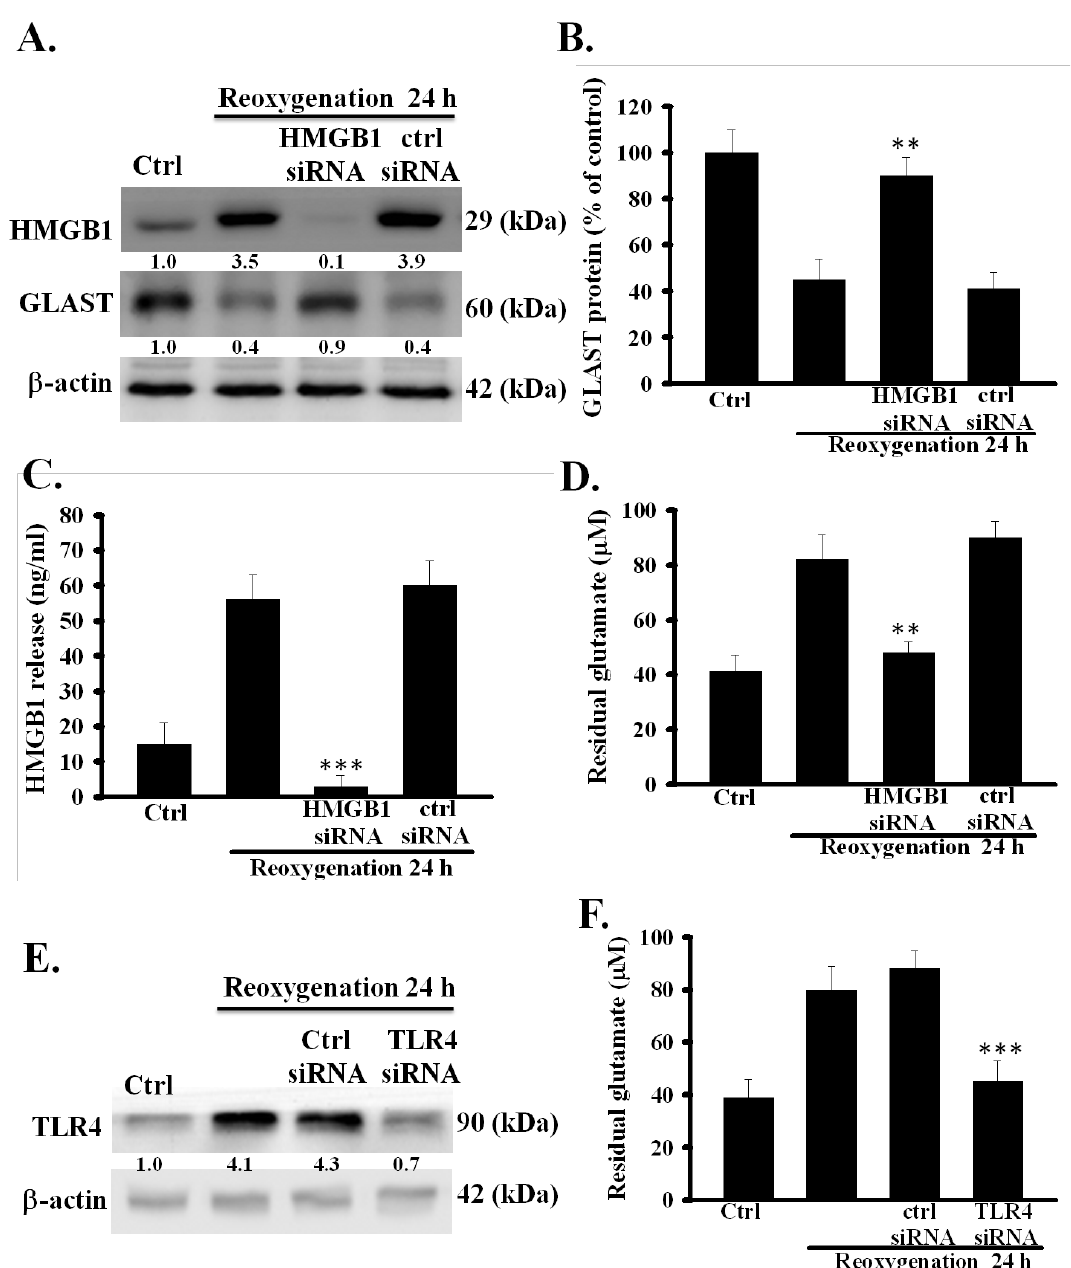
Figure 2. Effects of HMGB1 knockdown on OGD/R-impaired function of glutamate clearance in primary astrocytes. HMGB1 and control siRNA-treated astrocytes were exposed to OGD for 6 h followed by reoxygenation for 24 h. Thereafter, the expression of HMGB1 and GLAST protein ( A ) was examined using Western blot. Western blot of GLAST ( B ) was quantified using densitometry and ImageJ software. HMGB1 secretion ( C ) was analyzed using ELISA. The activity of glutamate clearance ( D ) was assayed at 24 h after reoxygenation. TLR4 and control siRNA-treated astrocytes were exposed to OGD/R insult. The expression of TLR4 ( E ) was examined by Western blot 24 h later. Activity of glutamate clearance in TLR4 and control siRNA-treated astrocytes was assayed at 24 h after reoxygenation ( F ). ** p < 0.01, *** p < 0.001 vs. control siRNA group. Data are presented as mean ± SEM, n = 6–8. OGD/R, oxygen-glucose deprivation/reoxygenation; HMGB1, high-mobility group box 1; TLR4, toll-like receptor 4; GLAST, glutamate aspartate transporter; n , number of repeated examinations.